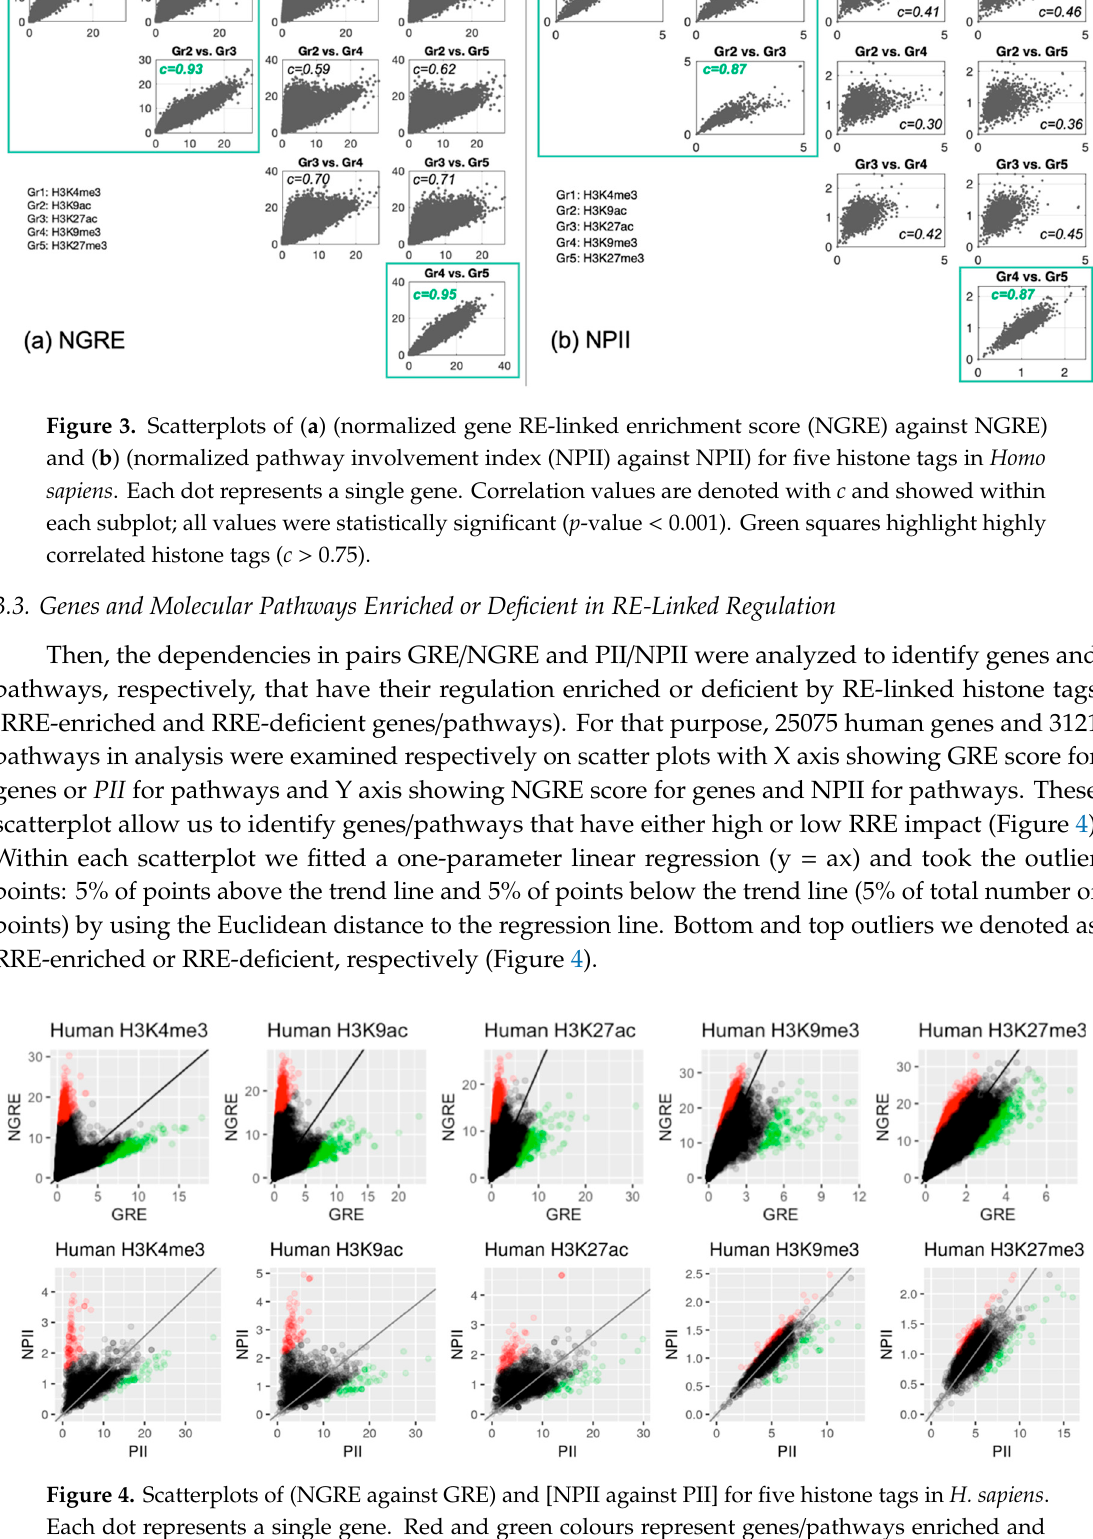
Figure 2. Correlations of histone profiles with the RNA sequencing gene expression profiles available in ENCODE database.